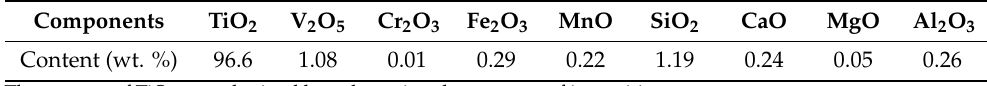
Figure 2. XRD pattern of the precipitate by hydrothermal precipitation. Table 3. Composition of the product of hydrothermal precipitation.